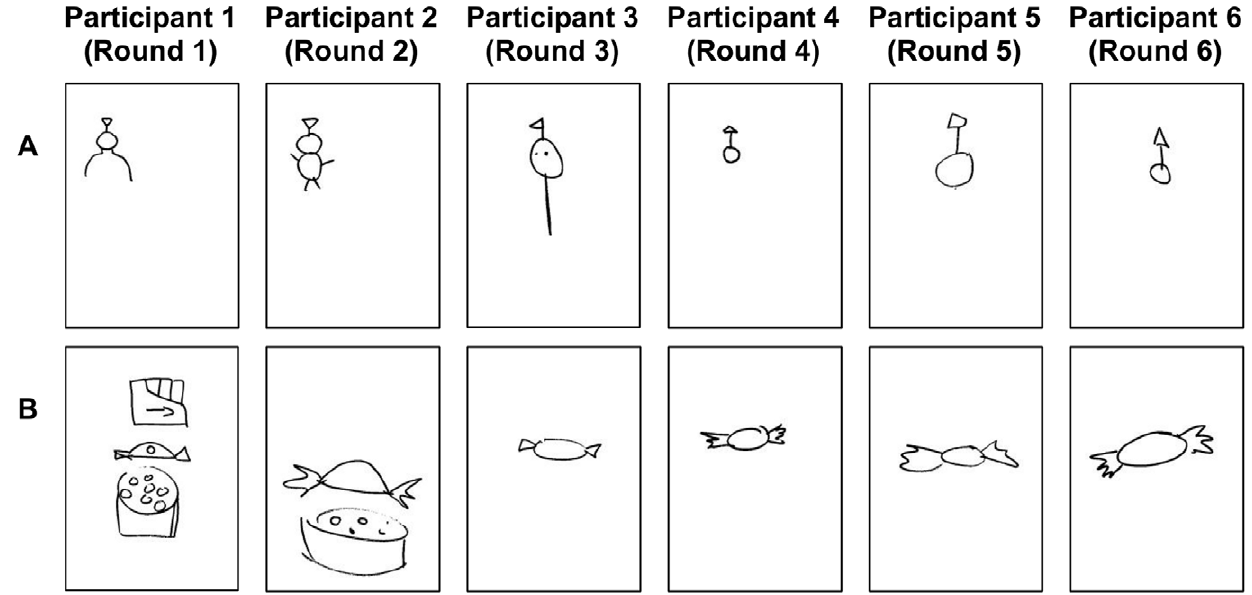
Figure 2. Example drawings of one of the target concepts (purple) from two microsocieties. Panels A and B each display the drawings of one chain of participants. Participant 5 joined the test group in round 2 and participant 6 joined the test group in round 3 so neither witnessed the signs produced in the initial rounds (see Table 1). Each drawing was completed on a sheet of A4 paper and they are displayed to scale here.